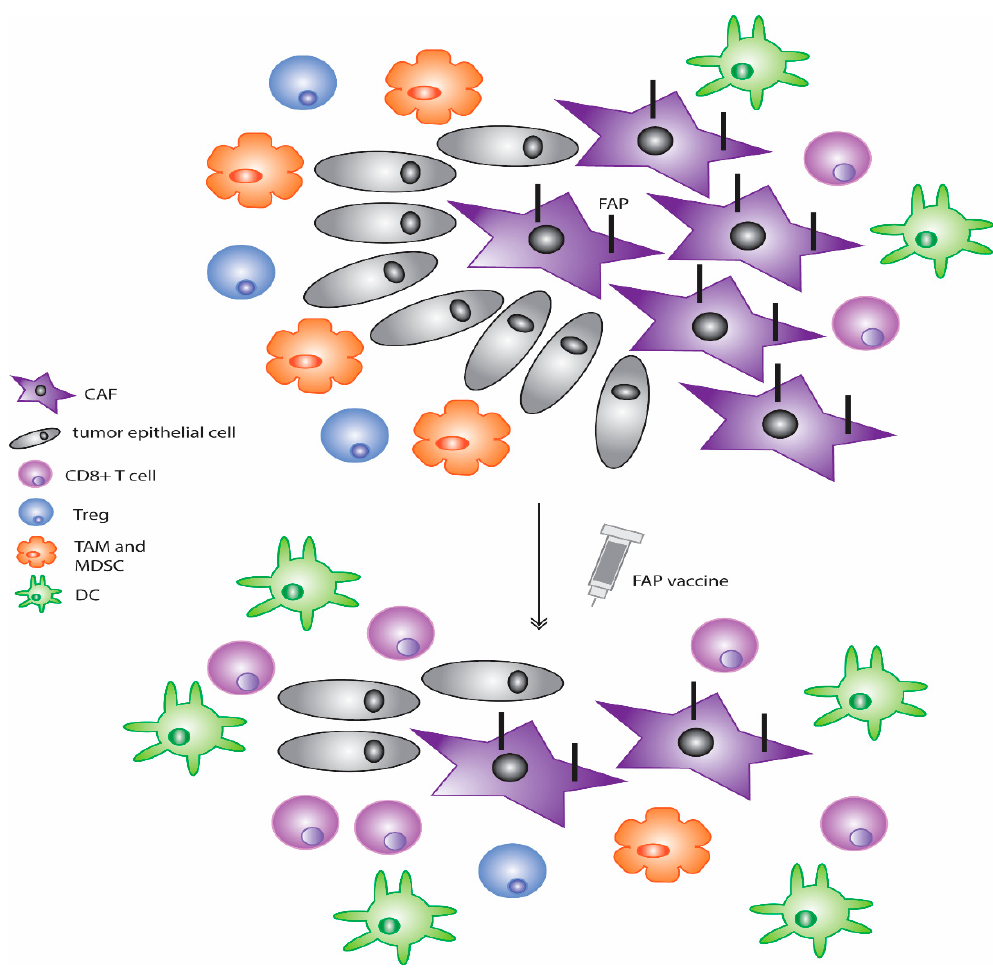
Figure 2. Vaccines against FAP are a new way to target the CAF population in many tumor types. These agents have been shown in multiple cancer models to decrease primary tumor as well as metastatic growth, increase CD8+ T-cell and DC activity, decrease CD8+ T-cell exhaustion, and lessen immunosuppressive cells such as Tregs, TAMs, and MDSCs, as well as reduce the number of FAP-positive CAFs present in the tumor.